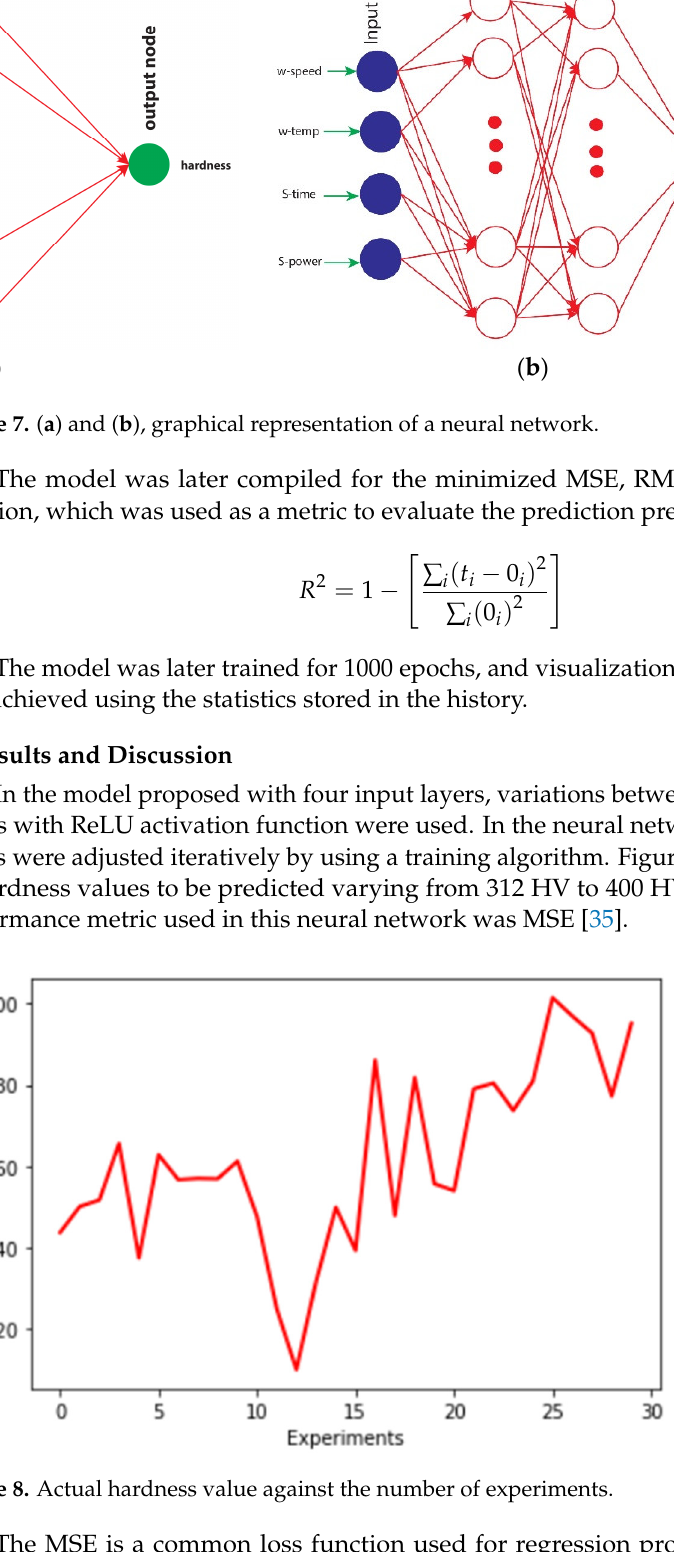
Figure 9. Plots of MSE against number of epochs.